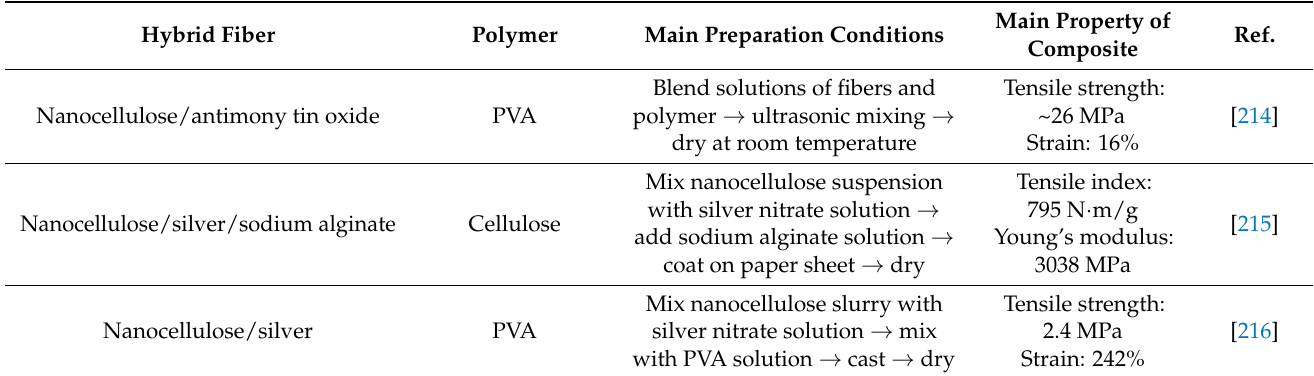
Table 3. The main preparation conditions and properties of the hybrid polymer composites.